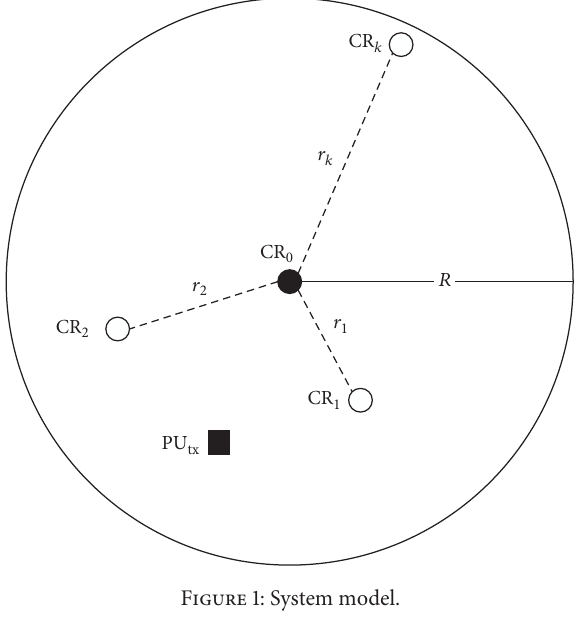
Figure 1: System